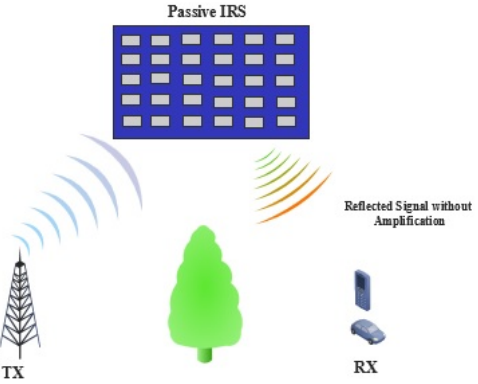
Figure 1. Block diagram of an IRS-enhanced wireless system.